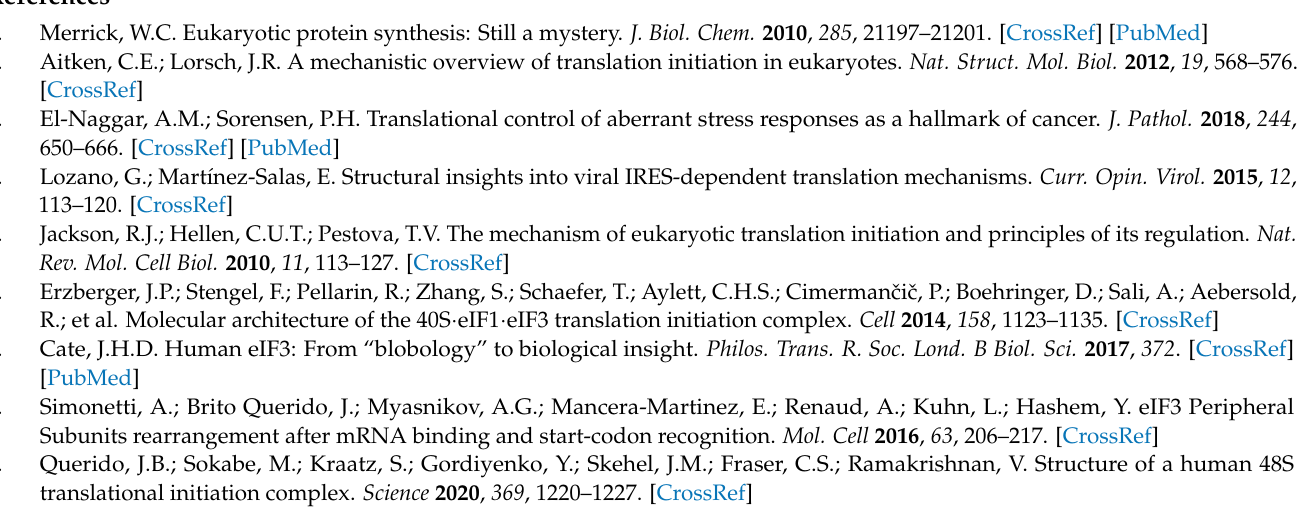
translation, Table S2: Gene ontology term over-representation analysis for biological process, Table S3: Gene ontology term over-representation analysis for cellular component, Table S4: Gene ontology term over-representation analysis for molecular function, Table S5: Details of gene ontology term over-representation analysis in HEK-293T and